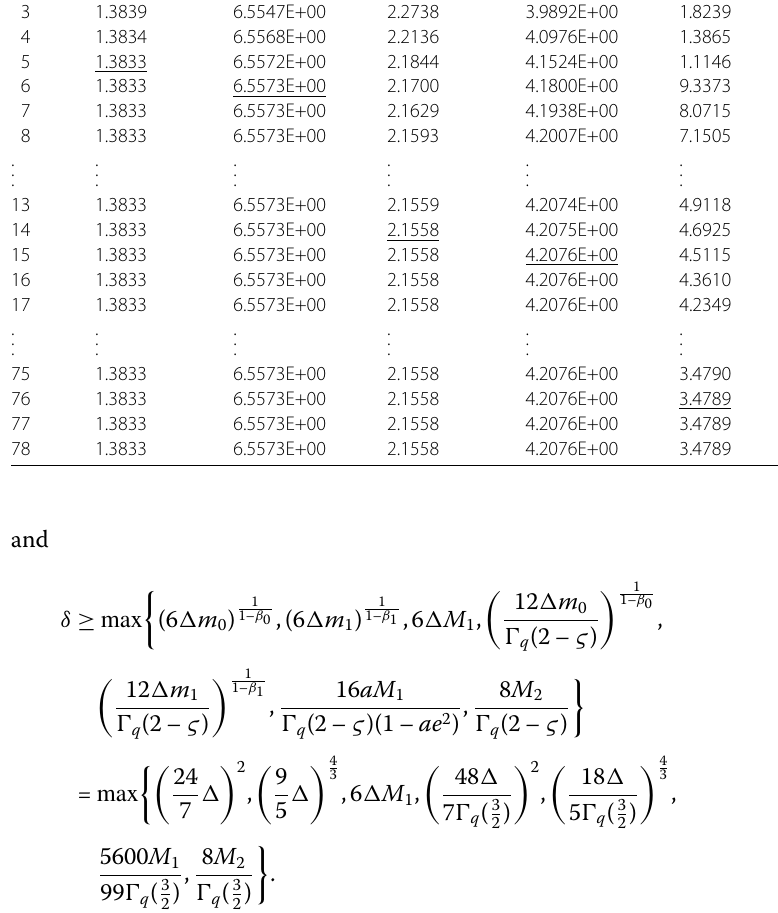
in Example 4.1 (Algorithm 1)